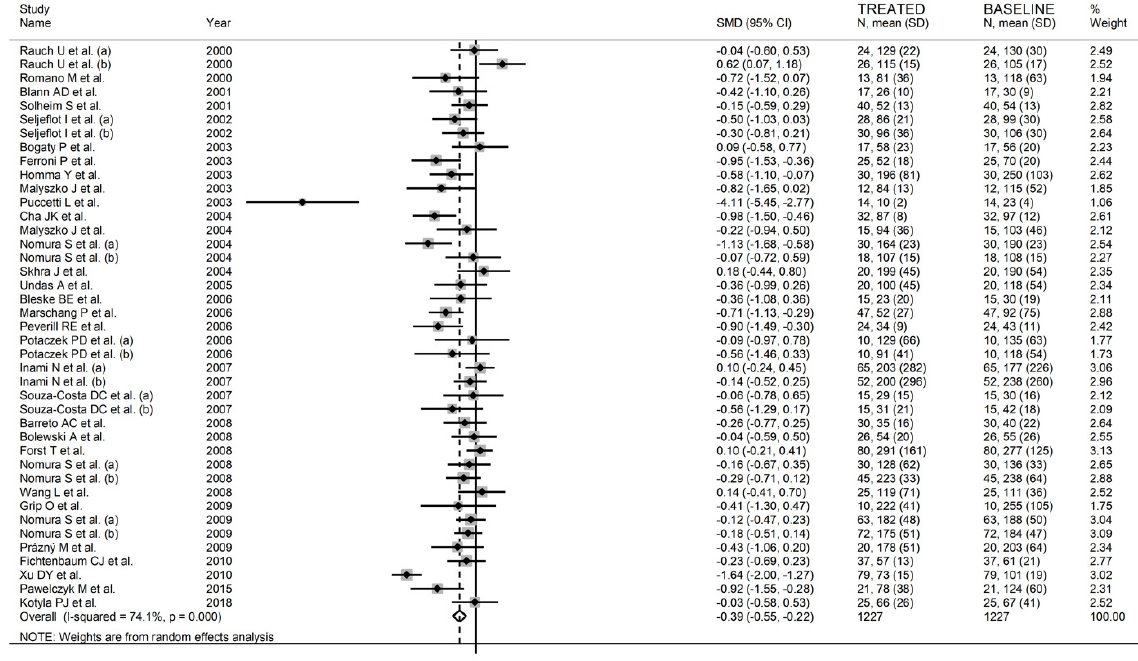
Figure 2. Forest plot of circulating P-Selectin concentrations before and after statin treatment.